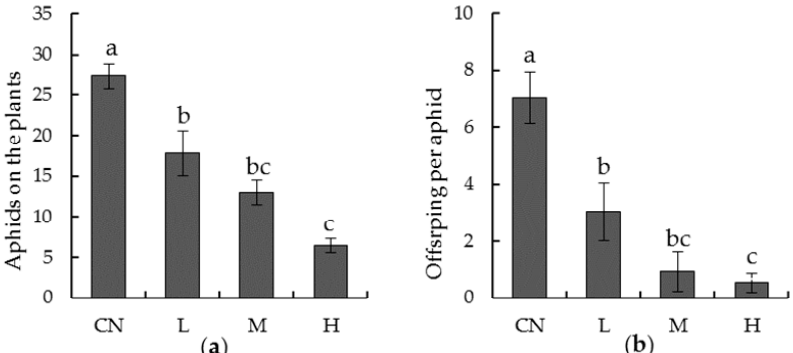
Figure 2. Survival of ( a ) tested aphids and ( b ) their progeny on oilseed rape seedlings that had been seed treated with imidacloprid. CN: Controls; L: Seed coated with low imidacloprid dose; M: Seed coated by medium imidacloprid dose; H: Seed coated by high imidacloprid dose. Bars indicate standard errors. Data were analyzed using analysis of variance (ANOVA) followed by Tukey’s test, and different lower-case letters indicate significant differences ( p < 0.05).